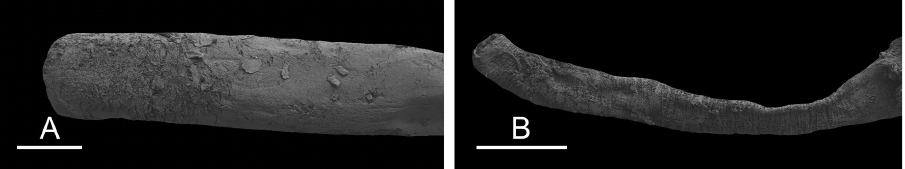
Figure 53. Penis, Wallaconchis achleitneri , Australia, Queensland (MTQ st117). A Scale bar 100 μm [2645] B Holotype, scale bar 100 μm [3534]. Reproductive system (Fig. 52A). In the posterior (hermaphroditic) part of the reproductive system, the oviduct is larger in circumference than the deferent duct. The spherical spermatheca joins the distal region of the oviduct through a short